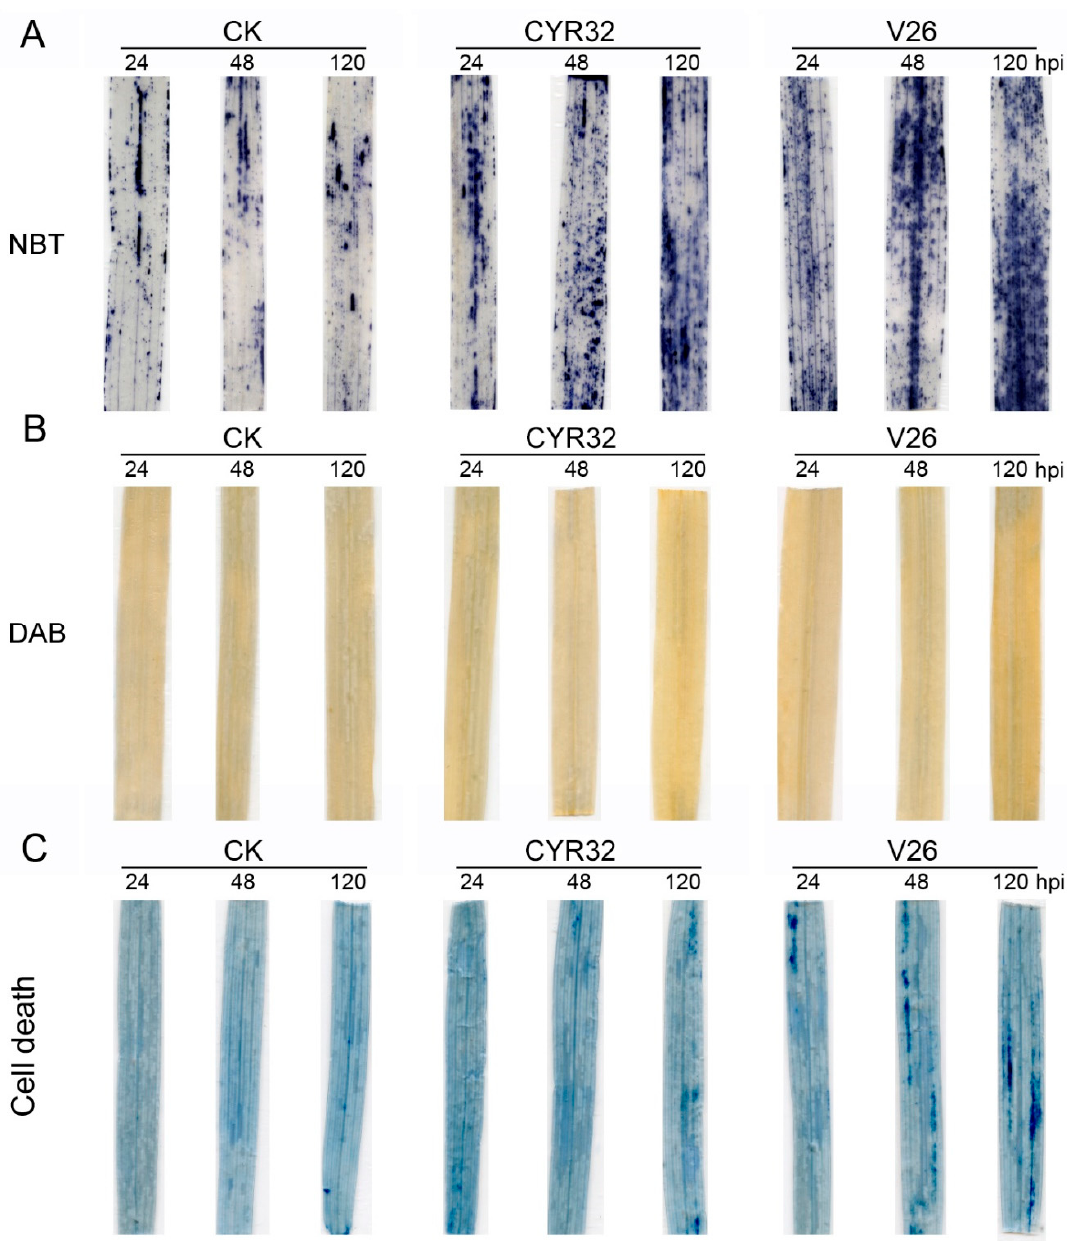
Figure 2. Measurement of reactive oxygen species (ROS) and cell death in wheat cultivar CM42 inoculated with CYR32 and V26. Histochemical analysis for superoxide anion radicals (O 2 ·− ) and hydrogen peroxide (H 2 O 2 ) by nitro blue tetrazolium (NBT) ( A ) and 3,3-diaminobenzidine (DAB) ( B ) staining, respectively. ( C ) Degree of cell death was visually detected by trypan blue staining. CK, un-inoculated wheat plants. 24–120 hpi represent 24, 48, and 120 h